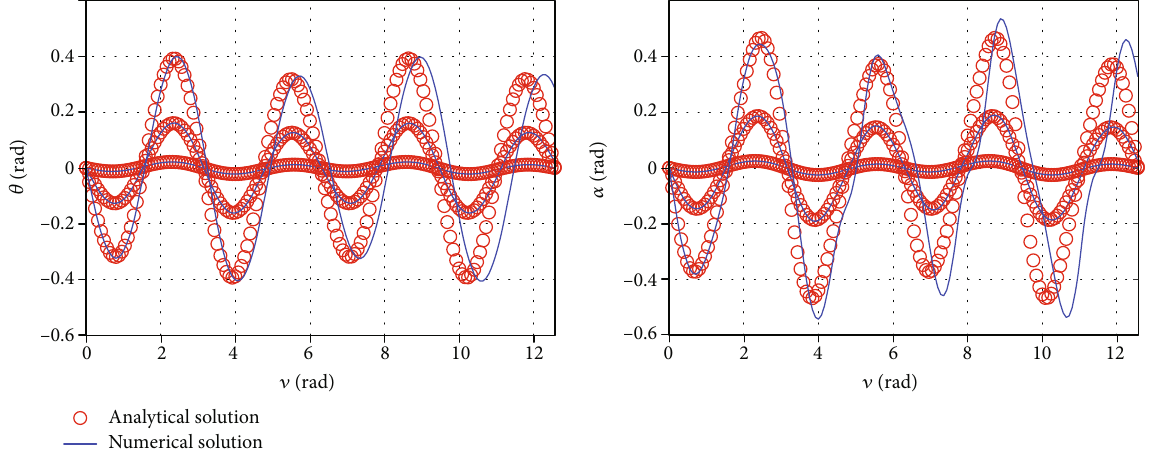
Figure 13: Periodic solutions given by asymptotic expansions and numerical results for di ff erent values of e under SR2.